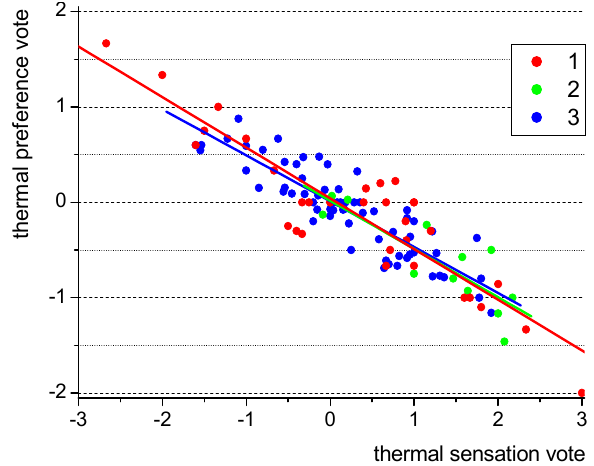
Figure 11. Thermal preference vote vs. thermal sensation vote: in the Courthouse (1), “A” building (2) and “Energies” (3) with the best fit linear approximations. (the red line is for the Courthouse, the green line for “A” building and the blue line for “Energis”).